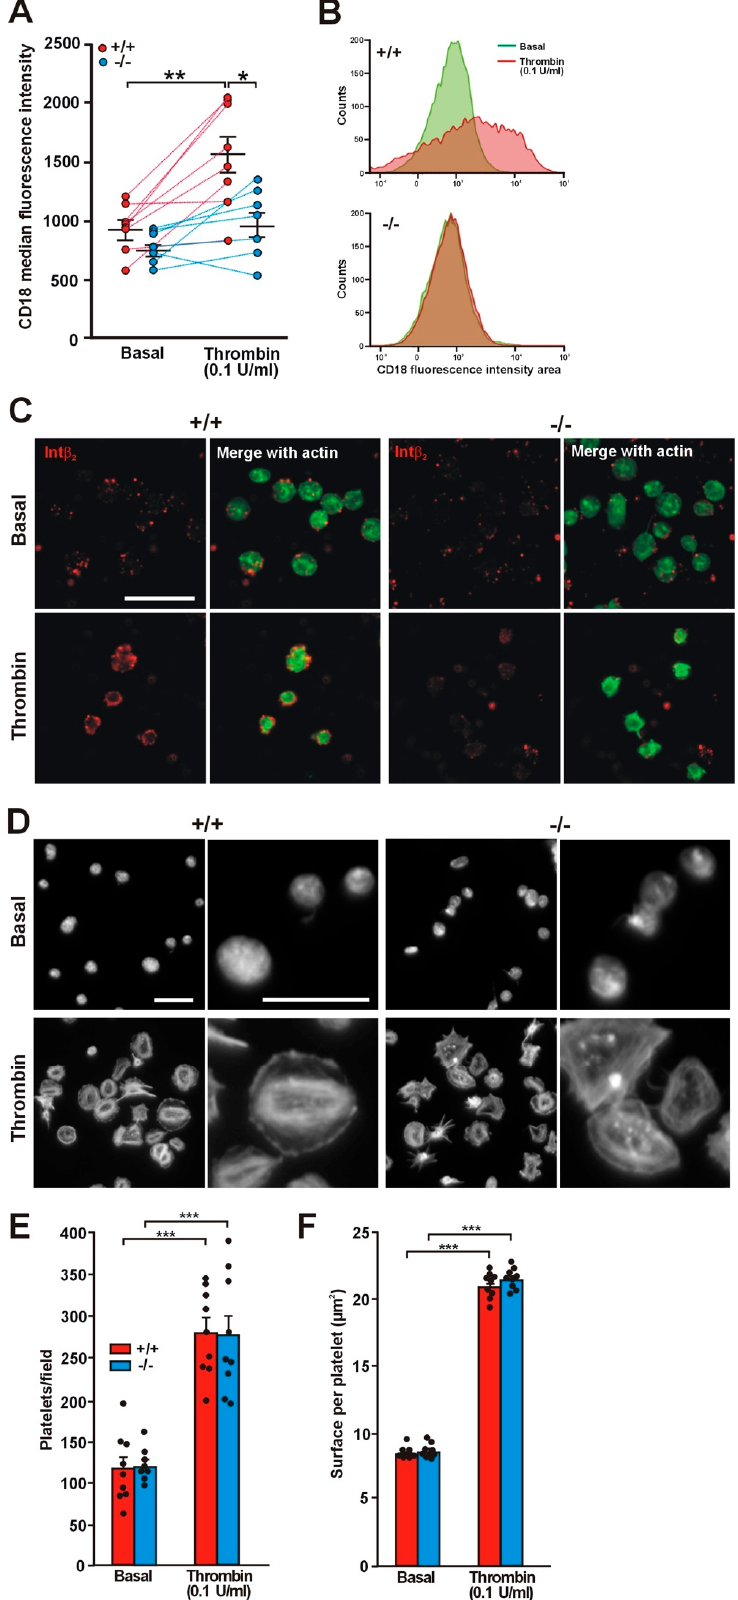
Figure 2. Impaired translocation of integrin β 2 in Coro1a deficient platelets. ( A ) Platelet surface integrin β 2 (CD18) was determined in PRP by flow cytometry both in basal conditions and upon